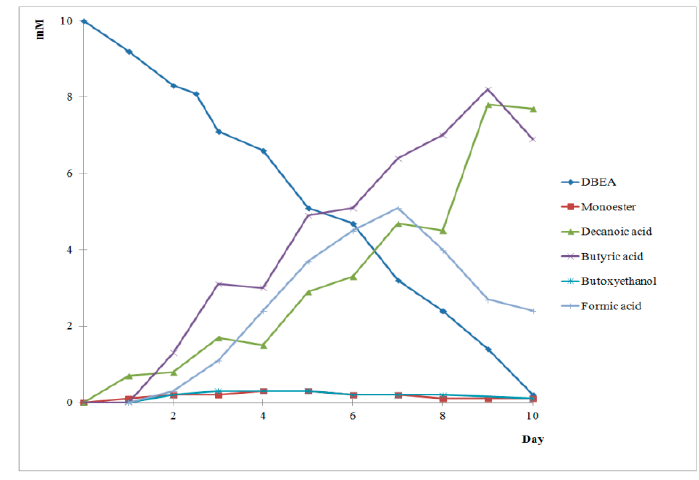
Figure 6. Biodegradation of DBEA in soil.